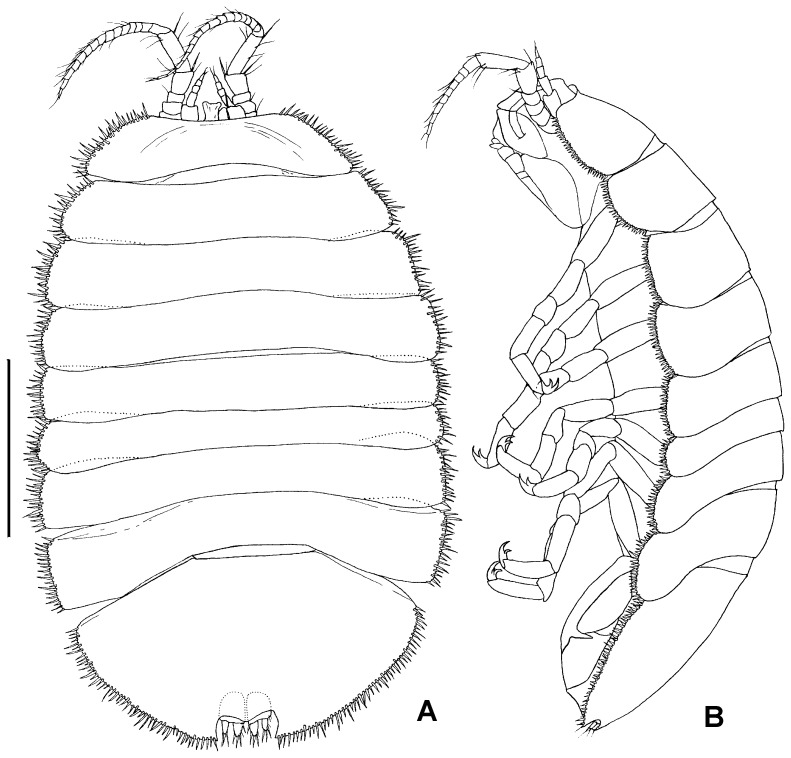
Holotype NHMUK 2014.268, male, total view.A) dorsal view, B) lateral view, scale – 1 mm